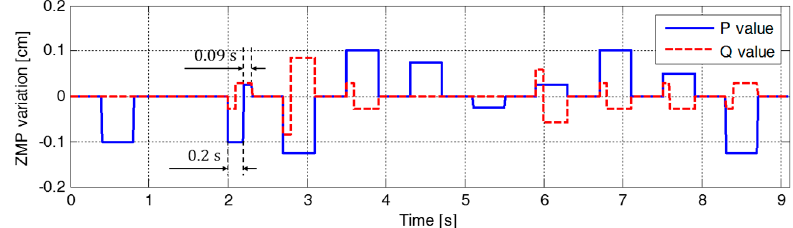
Figure 7. Variation in the parameters of the ZMP functions in the first simulation.